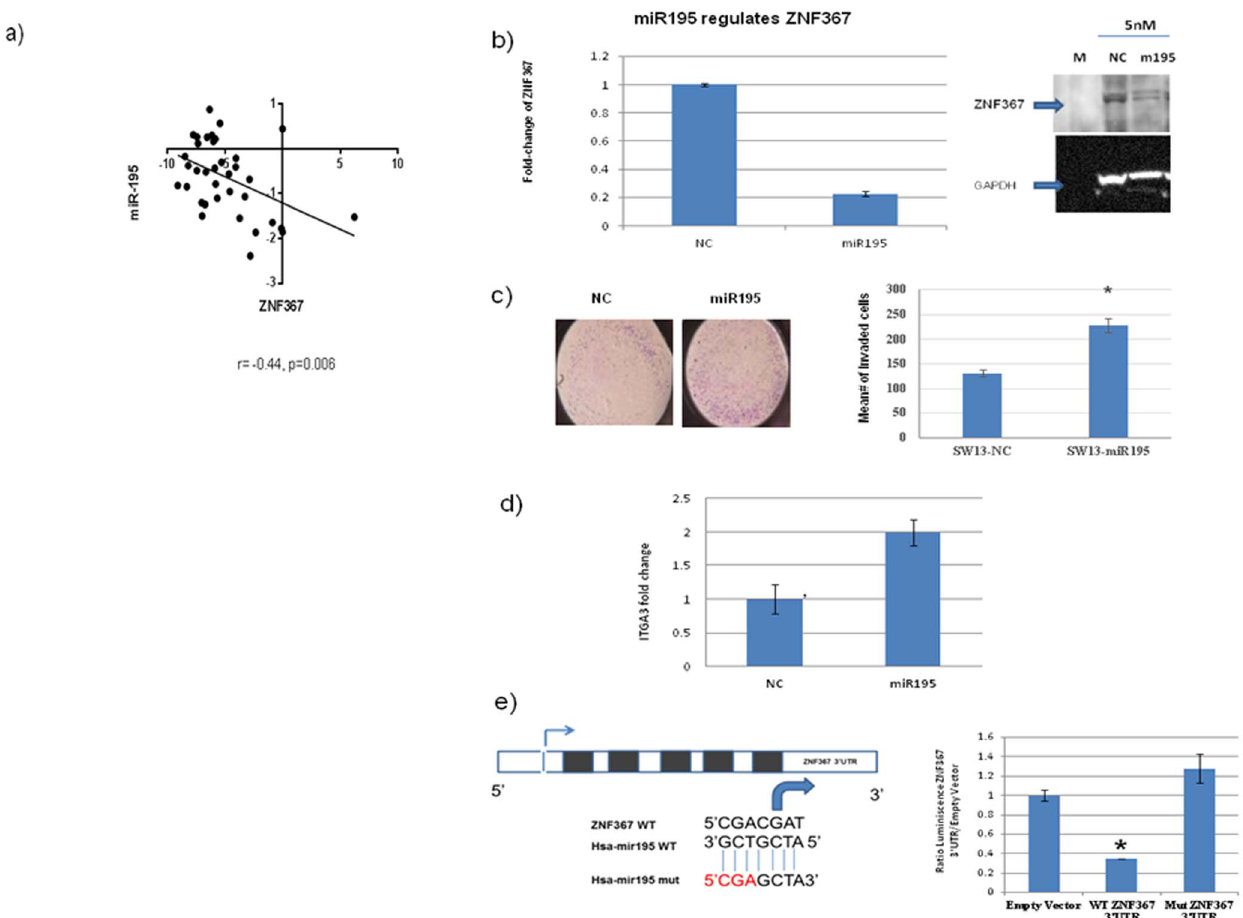
Figure 5. MiR-195 targets ZNF367. ( A ) The correlation between miR-195 and ZNF367 expression in an adrenocortical tumor. The Pearson correlation coefficient is indicated by r with its p value. ( B ) Ectopic overexpression of pre-miR-195 results in downregulation of ZNF367 . ZNF367 mRNA expression in SW13 cells transfected with pre-miR-195 and the pre-negative control at 5 nM for 24 hours (presented as a fold-change relative to the pre-negative control). Error bars represent 6 SEM. The right panel shows the Western blot of the ZNF367 protein from SW13 cells transfected with pre-miR-195 and the negative control. ( C ) Pre-miR-195 overexpression increases invasion in SW13 cells compared to the negative control. The right panel shows the mean number of invaded cells on the Y axis. ( D ) ITGA3 mRNA expression is increased after transfection of miR-195 and the negative control in SW13 cells. Error bars represent 6 SEM. ( E ) The binding site of miR-195 in the ZNF367 3 9 UTR, along with the mutant construct in the predicted seed region. In the right panel, the luciferase assay demonstrates decreased luminescence in SW13 cells co-transfected with miR-195 and the negative control at 5 nM, with the empty vector, wild-type ZNF367 3 9 UTR, or MUT- ZNF367 3 9 UTR vector (mutated in the first three nucleotides of the seed sequence). The luminescence was read after 24 hours of transfection. The Y axis represents the ratio of ZNF367 3 9 UTR to the empty vector. *p value , 0.05 compared to the negative control. Error bars represent 6 SEM.